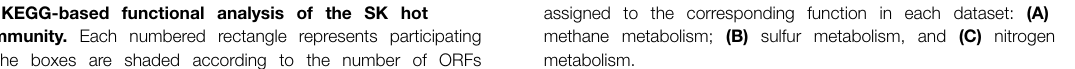
assigned to the corresponding function in each dataset: (A) methane metabolism; (B) sulfur metabolism, and (C) nitrogen